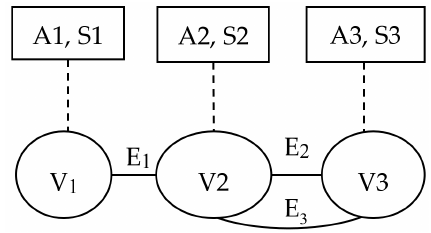
Figure 2. A simple Social-Attribute graph.